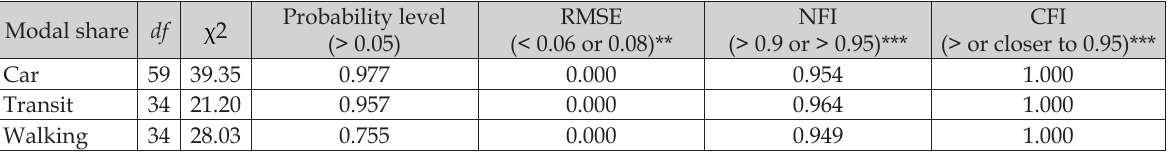
Table 6. Models fit